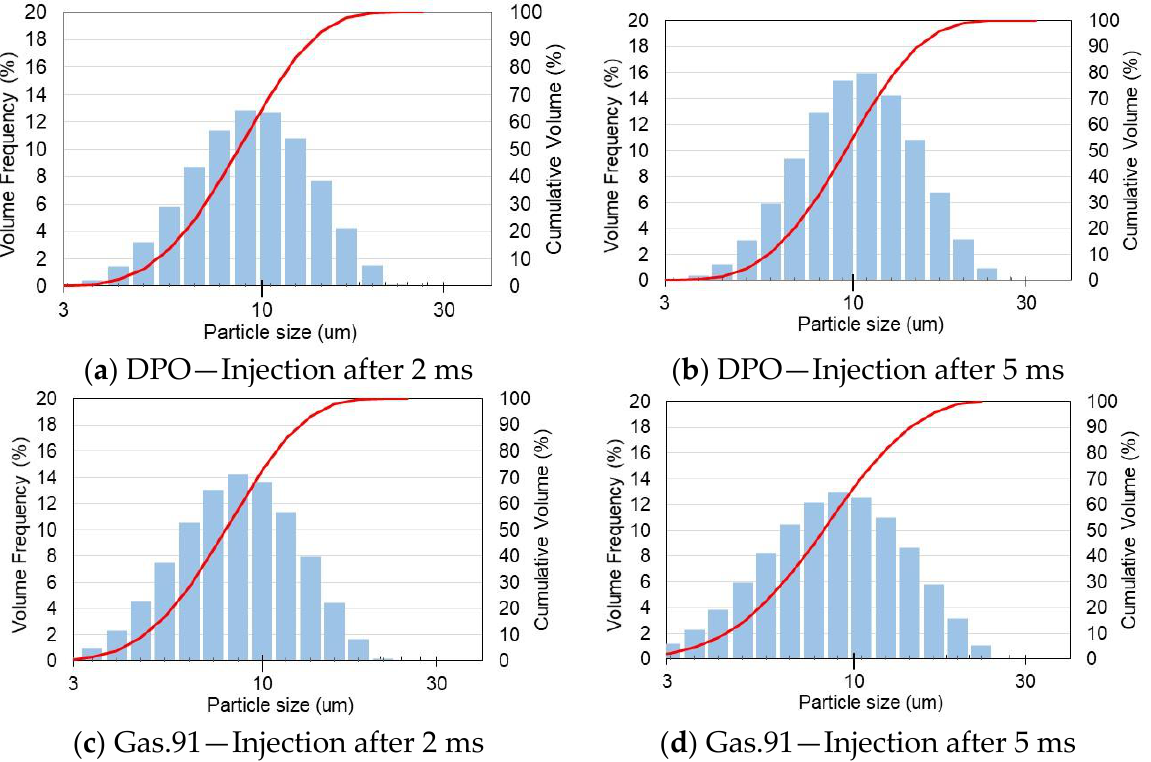
Figure 6. Averaged particle size distribution for the edge points at the beginning ( a , c ) and the end ( b , d ) of spraying for pyrolysis oil ( a , b ) and gasoline ( c , d ). Interestingly, the average pyrolysis oil droplet SMD is slightly larger than the 91-RON gasoline droplet size by nearly 1 µ m, as observed in Figure 7, for both points located centrally and at the edge of the injected fuel stream. Furthermore, an increase in the SMD parameter was observed (Figure 7b,d) with the evolution of injection. This can be explained by droplets merging into larger droplets as a result of collision and coalescence. It is very probable, due to the high concentration of the atomized fuel droplets in the center of the stream and the high flow velocities of the droplets at the injector nozzle catching up droplets injected earlier. The SMD determined for central points is also higher for DPO in comparison to the 91-RON gasoline. The dashed lines show the trend channels in both analyzed cases of the location of the measurement